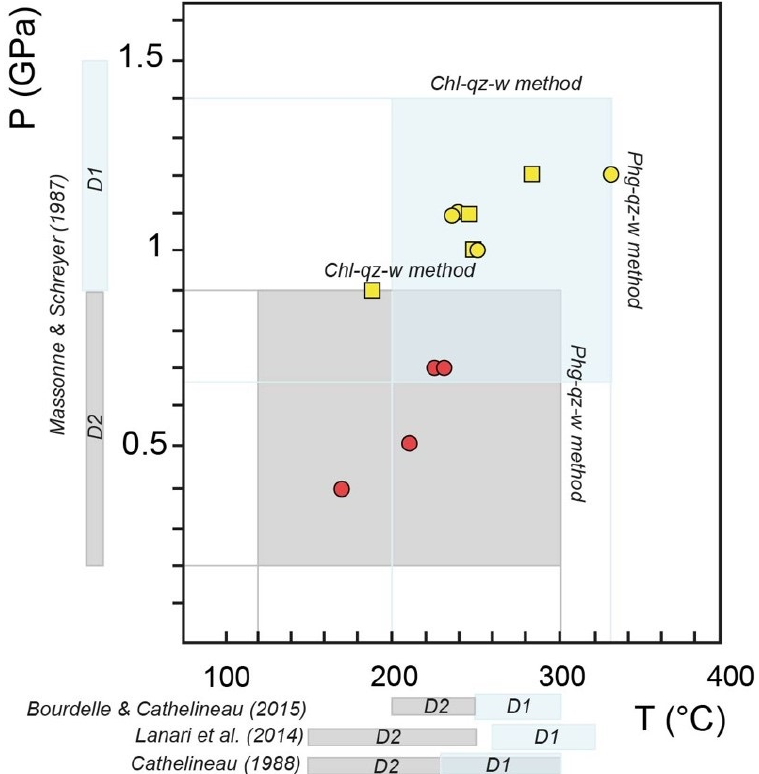
Figure 10. P/T diagram showing the results of the thermobarometric estimation performed on the samples ED18 and ED91. The light blue and grey pale squares in the P/T space indicate the areas constrained by the Chl-qz-wt [54] and Phg-qz-wt [103] methods; the yellow and red small squares and circles indicate the P–T equilibrium conditions of single selected Chl-Phg couples (see S3 Supplementary Materials for more details) obtained with Chl-Phg-qz-wt [52] method. Along the Y and X axes the used geothermobarometers are reported with the range values related to D1 and D2 phases.